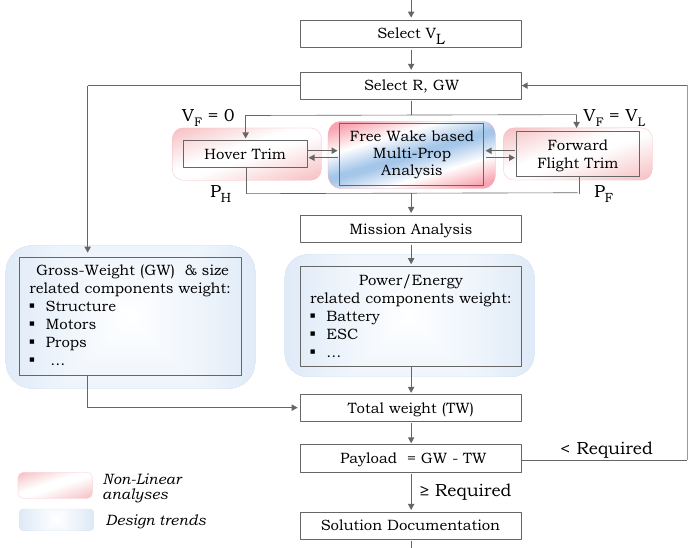
Figure 17. Searching for vehicles of various radii and gross-weights that accomplish a given mission for an assumed forward flight